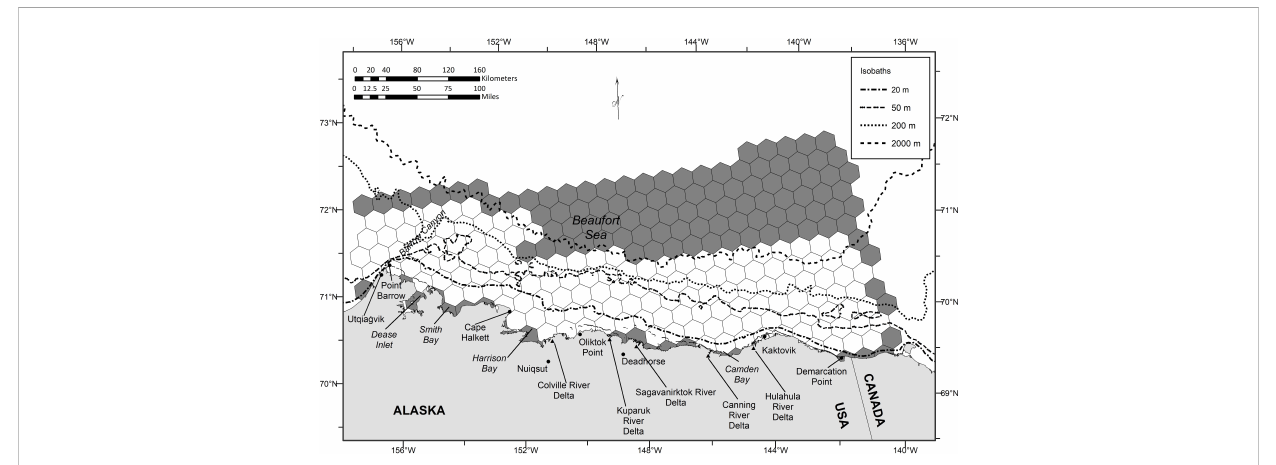
FIGURE 1 Study area in the western Beaufort Sea. Unshaded hexagonal cells represent those that the spatial optimization models could select to be delineated as Biologically Important